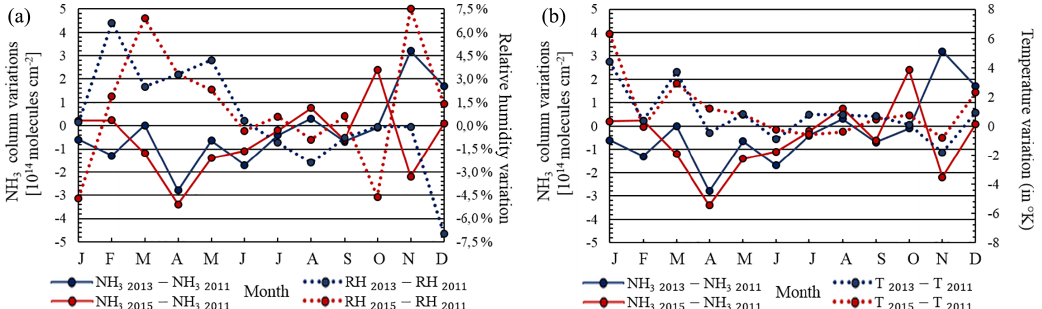
Figure 6. (a) Monthly variation of NH 3 ( g ) partial columns and relative humidity in 2013 and 2015 compared to 2011. (b) Monthly variation of NH 3 ( g ) partial columns and temperature in 2013 and 2015 compared to